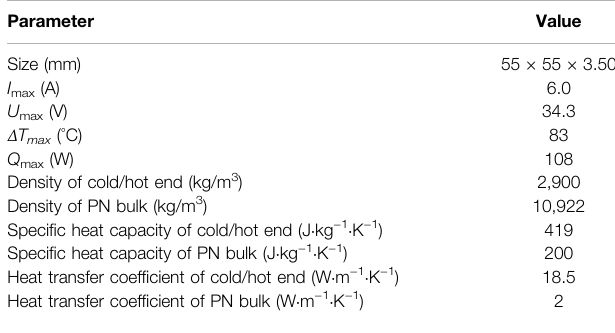
TABLE 3 | Physical parameters of the semiconductor ( T h (cid:1) 50 ° C).